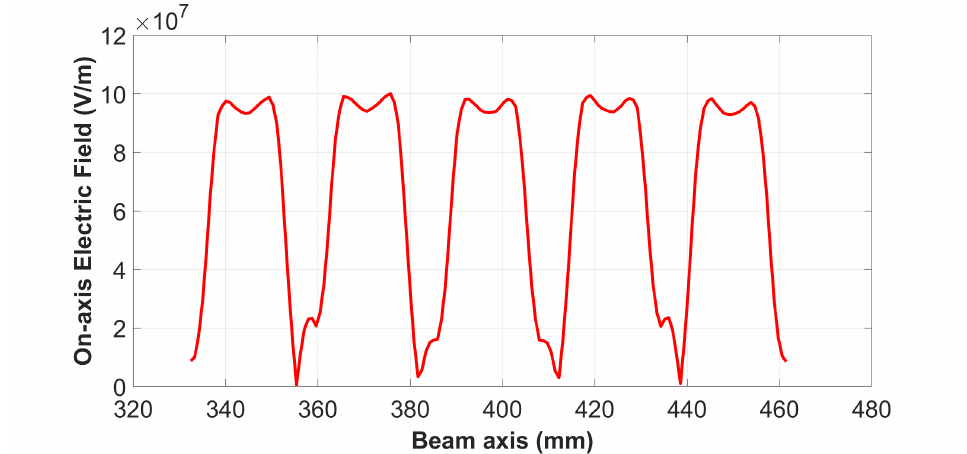
Figure 3. On-axis Accelerating electric field profile of the operating mode simulated with CST.